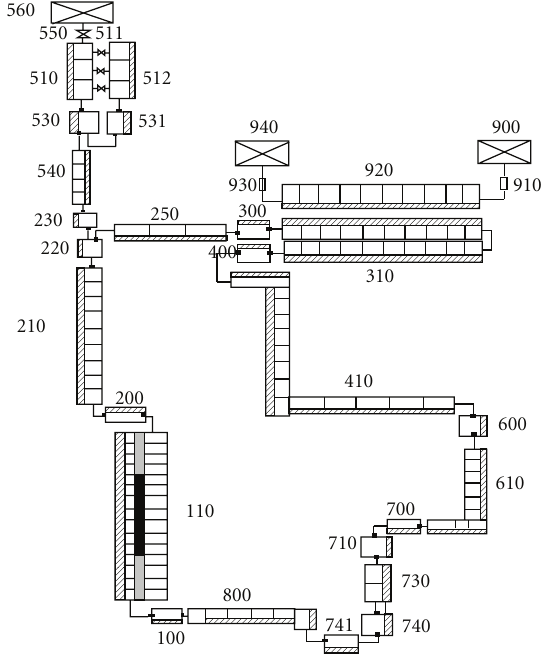
Figure 22: RELAP 5 nodalization TTL-1 apparatus case c.